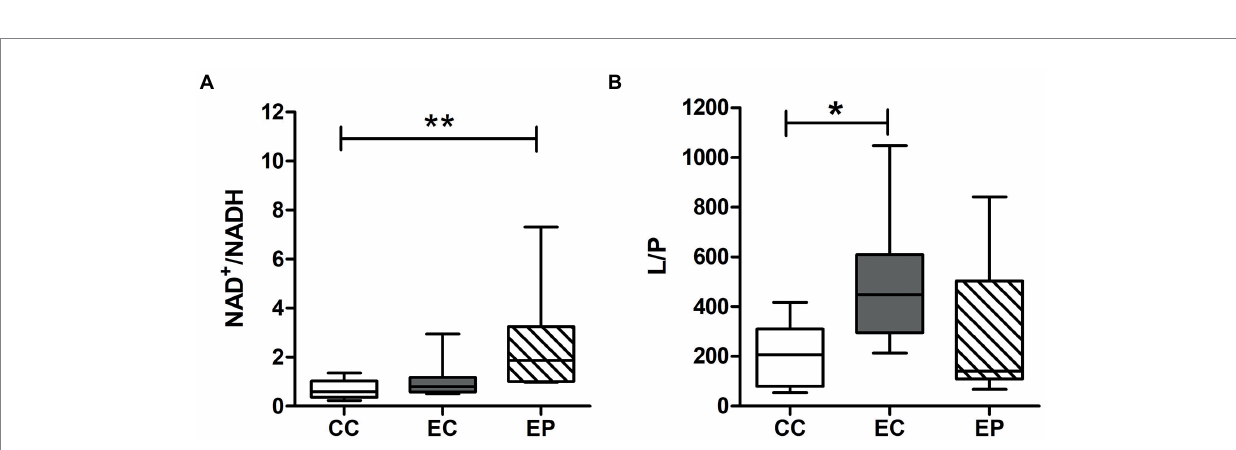
FIGURE 3 Effect of exogenous pyruvate pre-supplementation on (A) nicotinamide adenine dinucleotide (NAD + )/reduced NAD + (NADH) ratio and (B) lactate/ pyruvate (L/P) ratio in high-intensity interval exercise rats. *Significantly different to control non-exercise (CC) group ( p < 0.05). **Significantly different to control non-exercise (CC) group ( p <